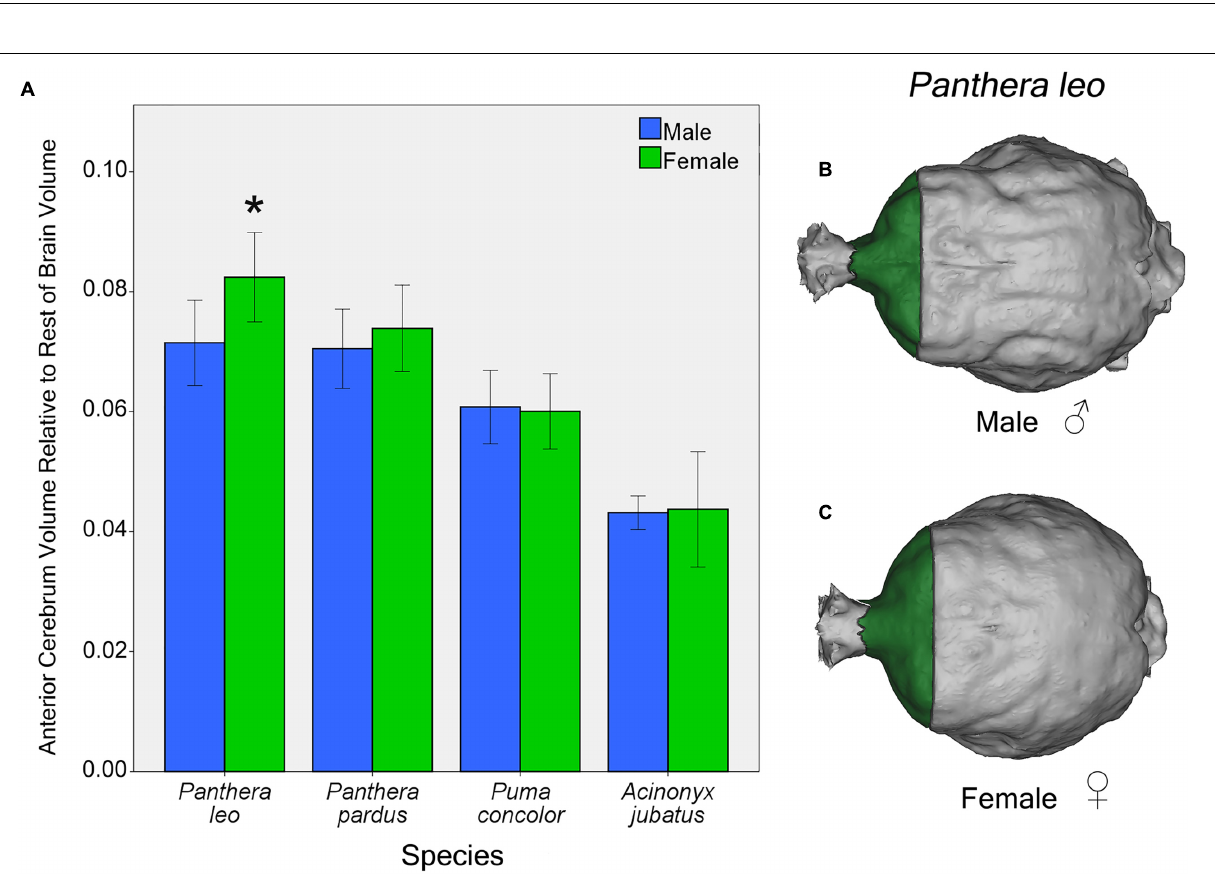
FIGURE 7 | Sex differences in AC volume relative to rest of endocranial volume in four felid species (A). Females lions possess a significantly larger relative AC than males [ t (12) = 2.54, p = 0.03]. Relative AC volume did not differ by sex in the leopard, cougar or cheetah. Dorsal view of male (B) and female (C) lion endocasts. Bars indicate 95%